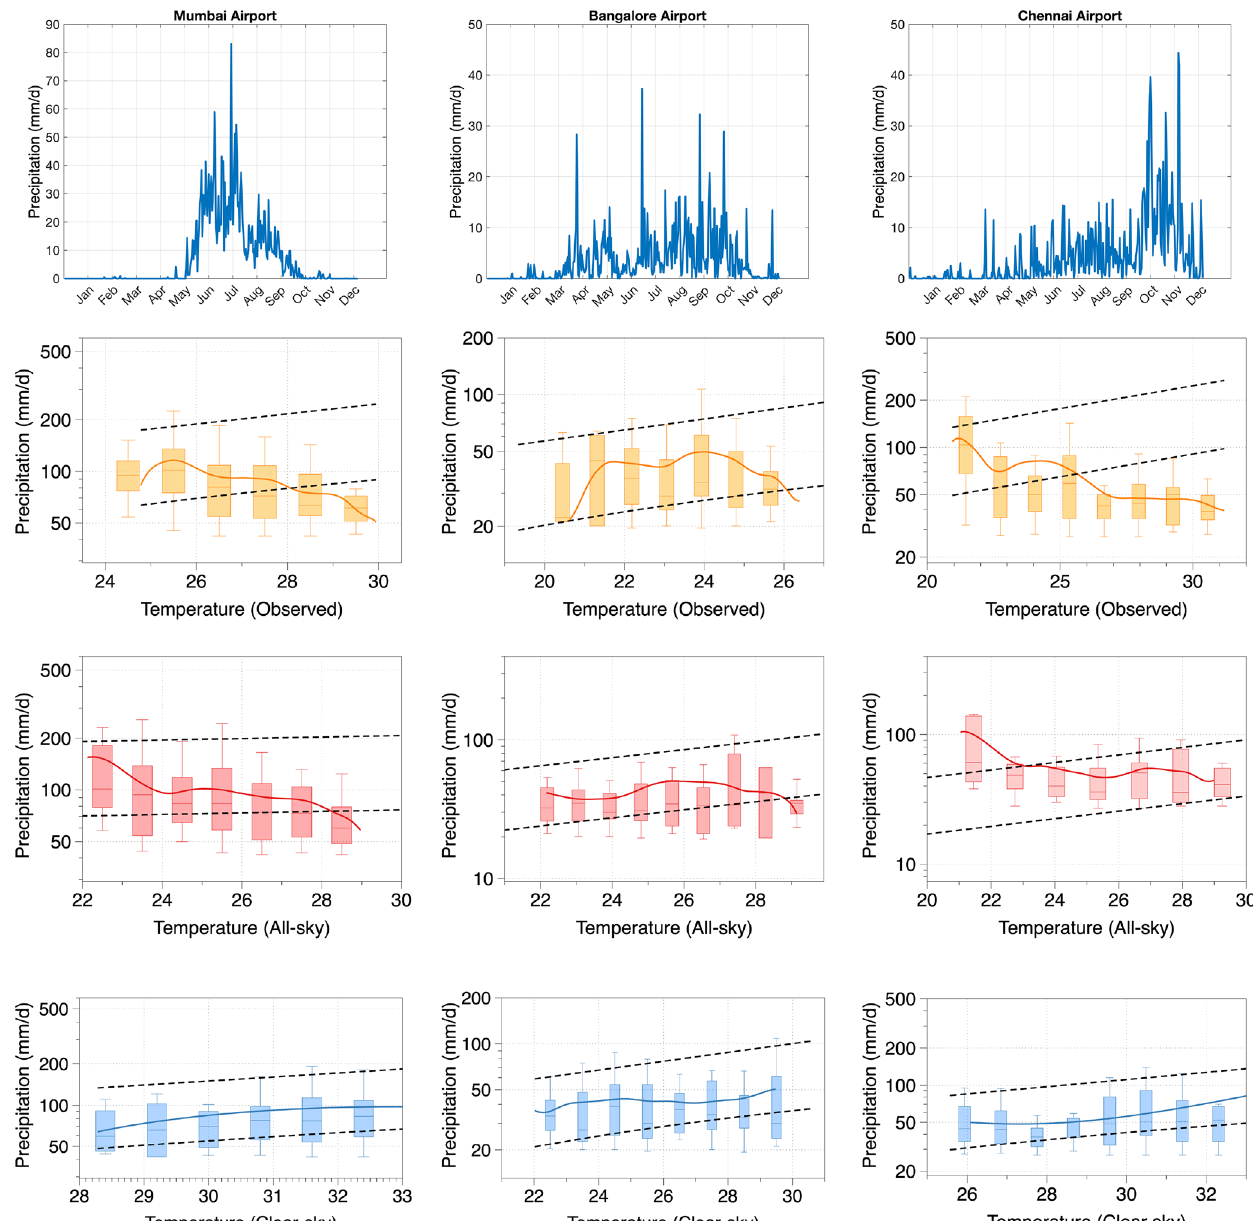
Figure A1. Row 1 shows the annual cycle of mean daily precipitation over GSOD sites in Mumbai airport, Bangalore airport and Chennai airport, respectively. Extreme precipitation–temperature scaling curves for observed temperatures (yellow), all-sky temperatures (red) and clear-sky temperatures (in blue) are presented for all the three sites. Solid yellow/red/blue lines indicate the LOESS regression lines. Dotted grey lines indicate the Clausius–Clapeyron (CC) scaling rate. Note the logarithmic vertical axis.